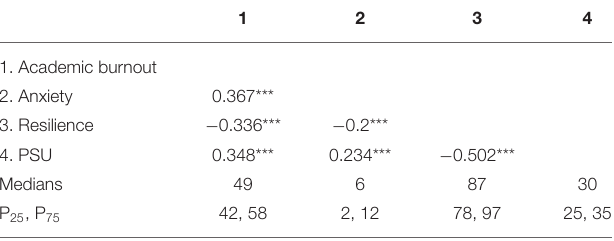
TABLE 1 | Correlations of the investigated variables.